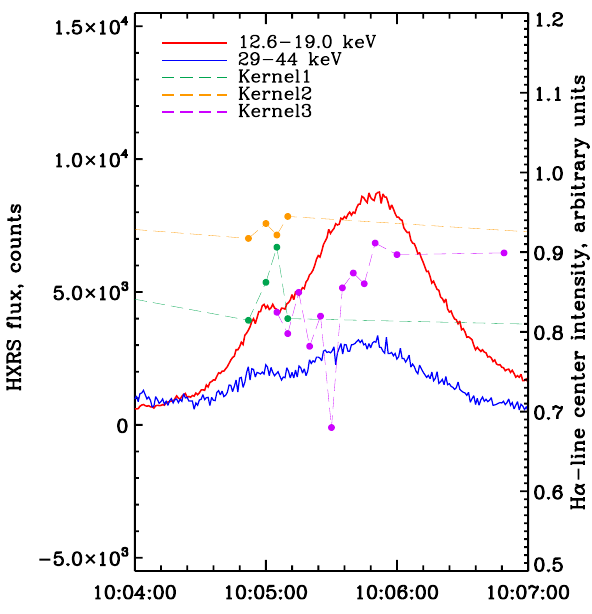
Fig. 11. Temporal evolution of HXR obtained by HXRS and H α - line center intensity of the kernels.